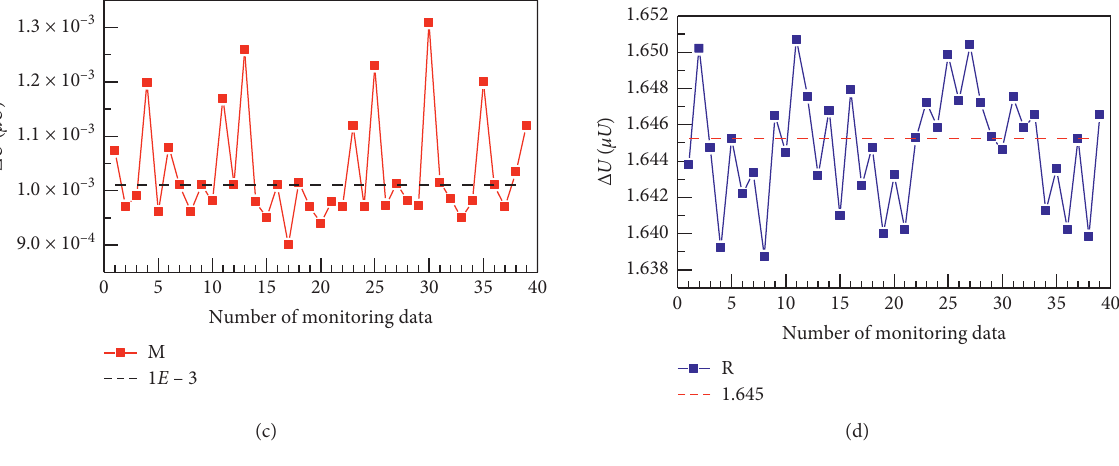
Figure 14: Test signal for crack independence.